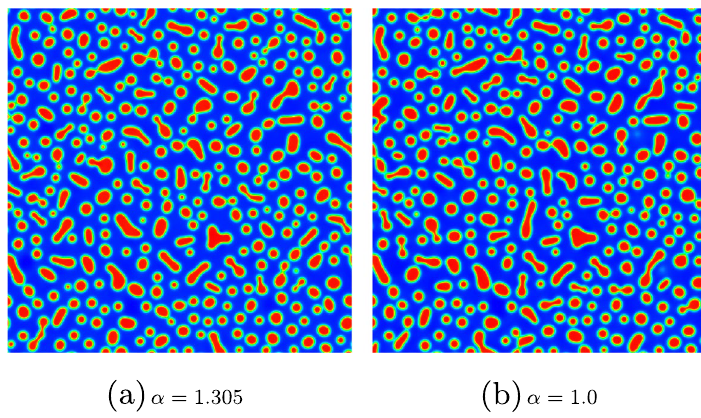
Fig. 12 Snapshots of the spinodal decomposition process, τ = 0.3 , T r = 0.8 , t = 800